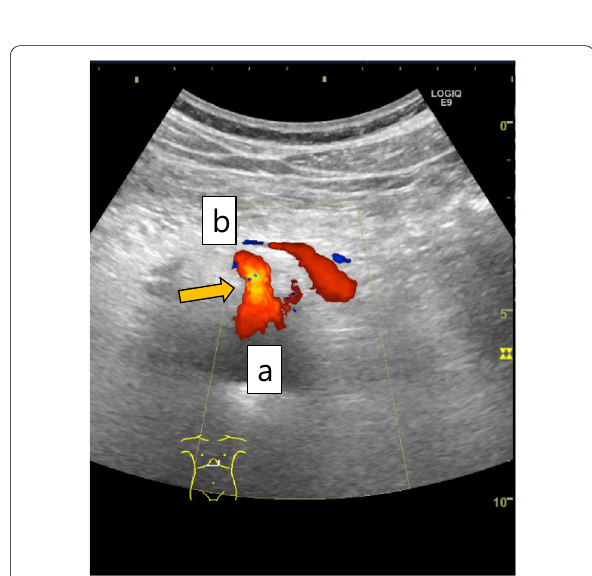
Fig. 5 Postoperative ultrasonography. No stenosis was seen at